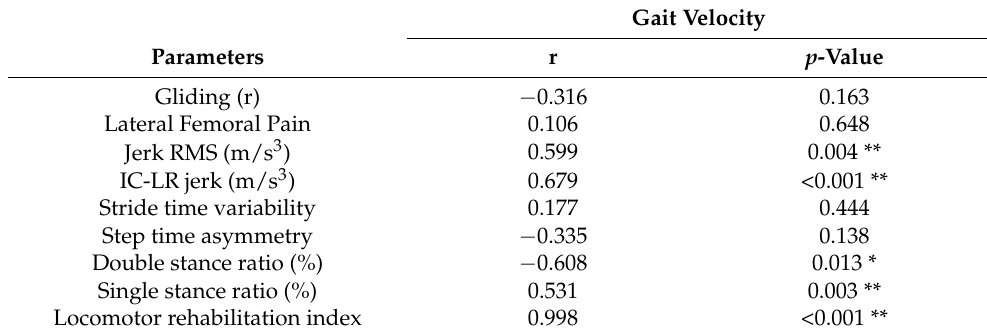
Table 3. Correlation between gait speed and each